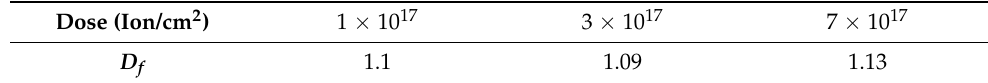
Table 6. The fractal dimension values of implanted